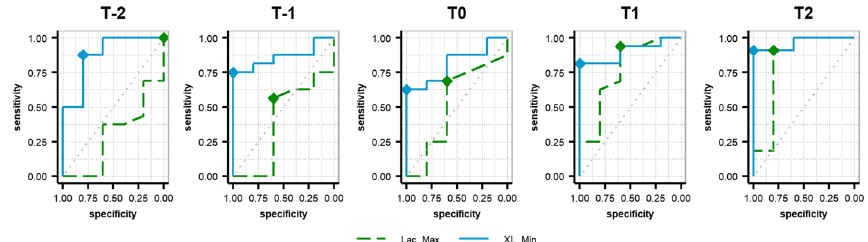
Fig. 3 ROC curves for maximum lactate values per subject per event (Lac_Max) and minimum XL values per subject per event (XL_Min) between the control group (CG) and the shock group (SG). All subjects were considered in the relevant time points by the shock criterion (MAP before shock; T0: shock; T1: 1 h after shock; T2: 2 h after shock